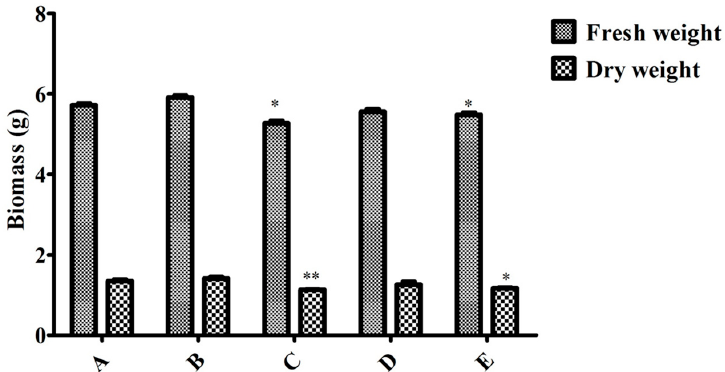
Figure 6. Effect of MeJA, endophytic bacteria and their combination on biomass in flask culture.